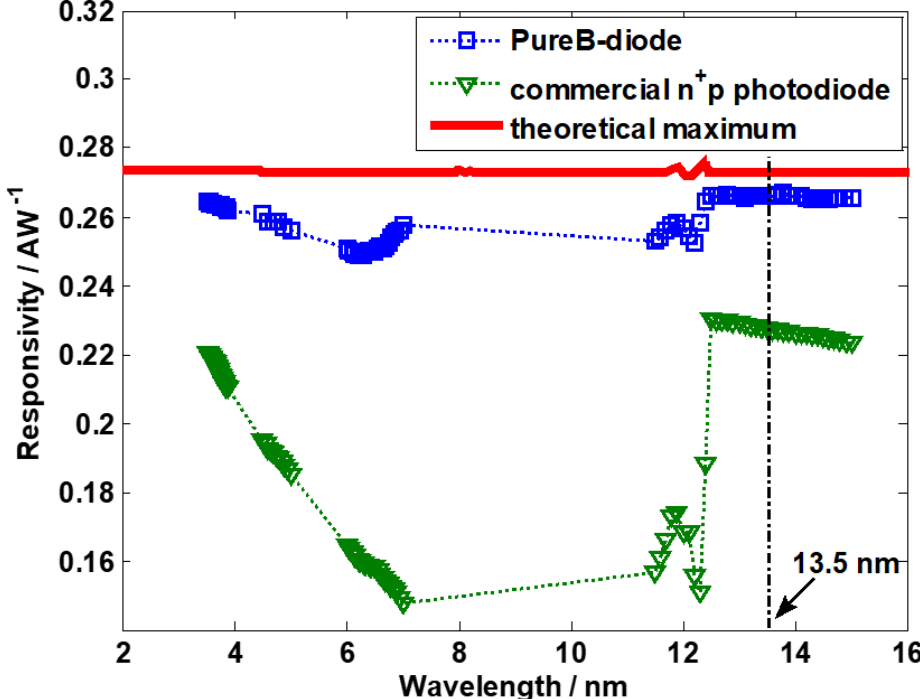
Figure 3. Measured spectral responsivity (squares) of boron-silicon photodiode in the extreme ultra violet (EUV) spectral range, compared with a commercial n+p photodiode and the theoretically attainable values for an ideal Si-based photodetector